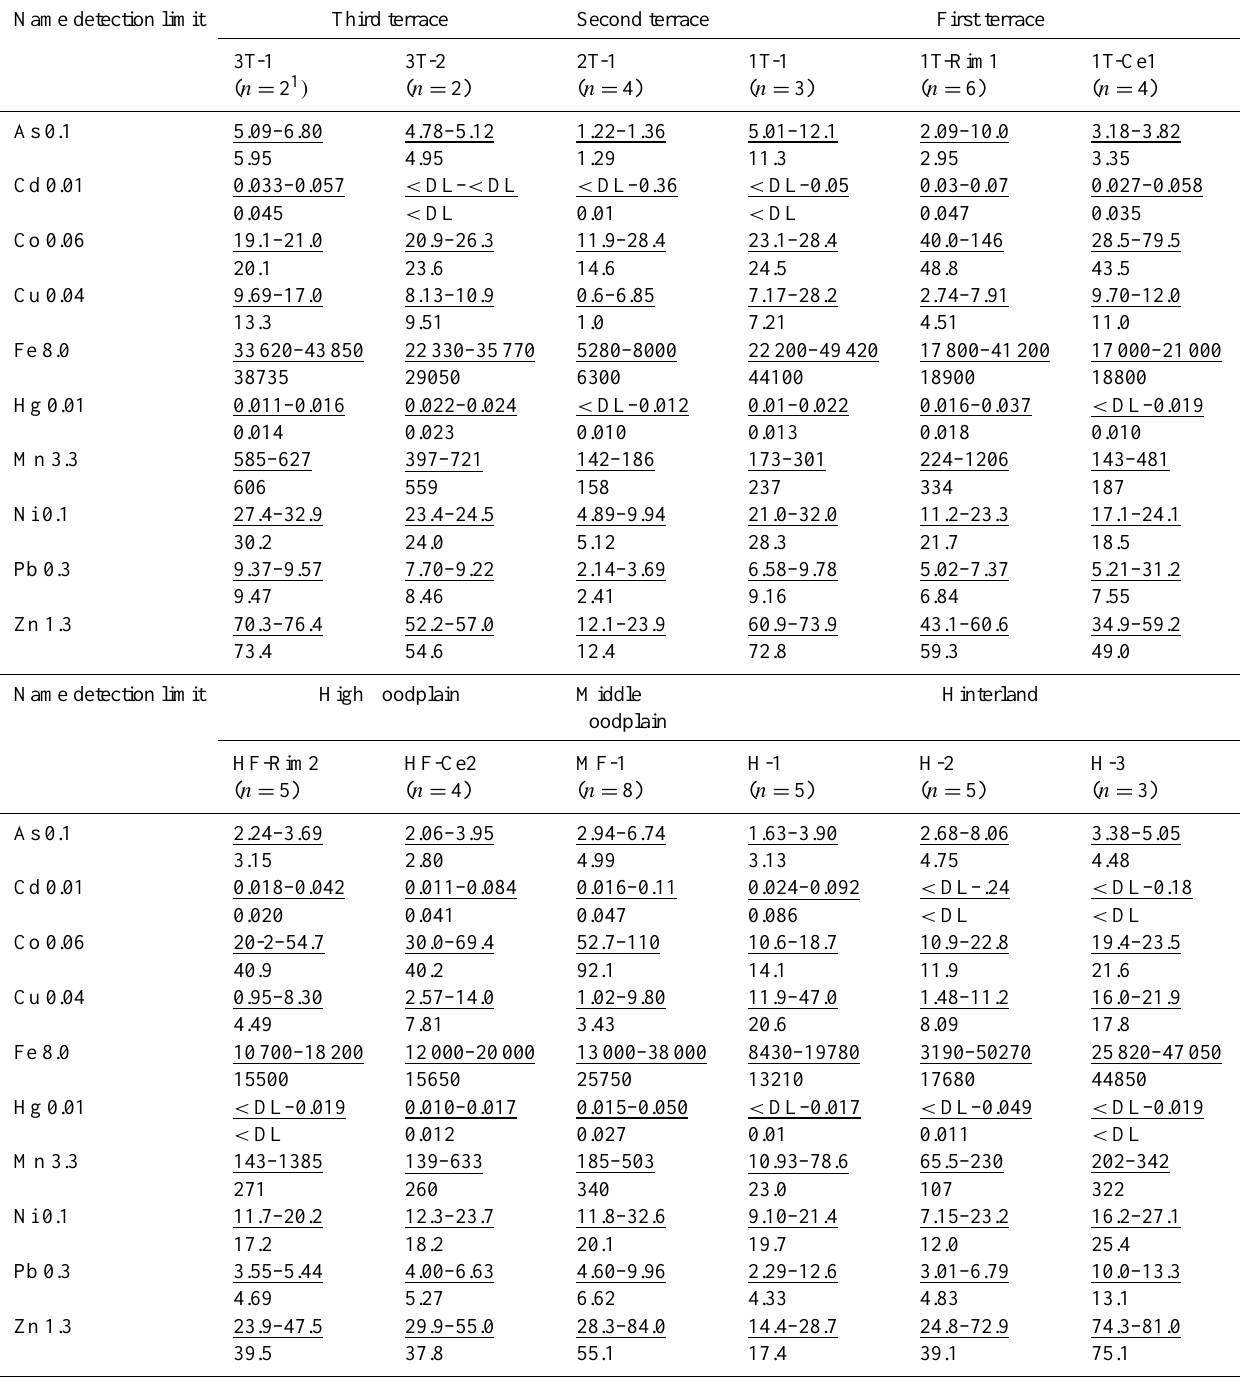
Table 4. Range (min–max) (numerator) and median values (denominator) of the trace metals in mg kg − 1 determined in the soils of investi- gated units in northern Siberia and detection